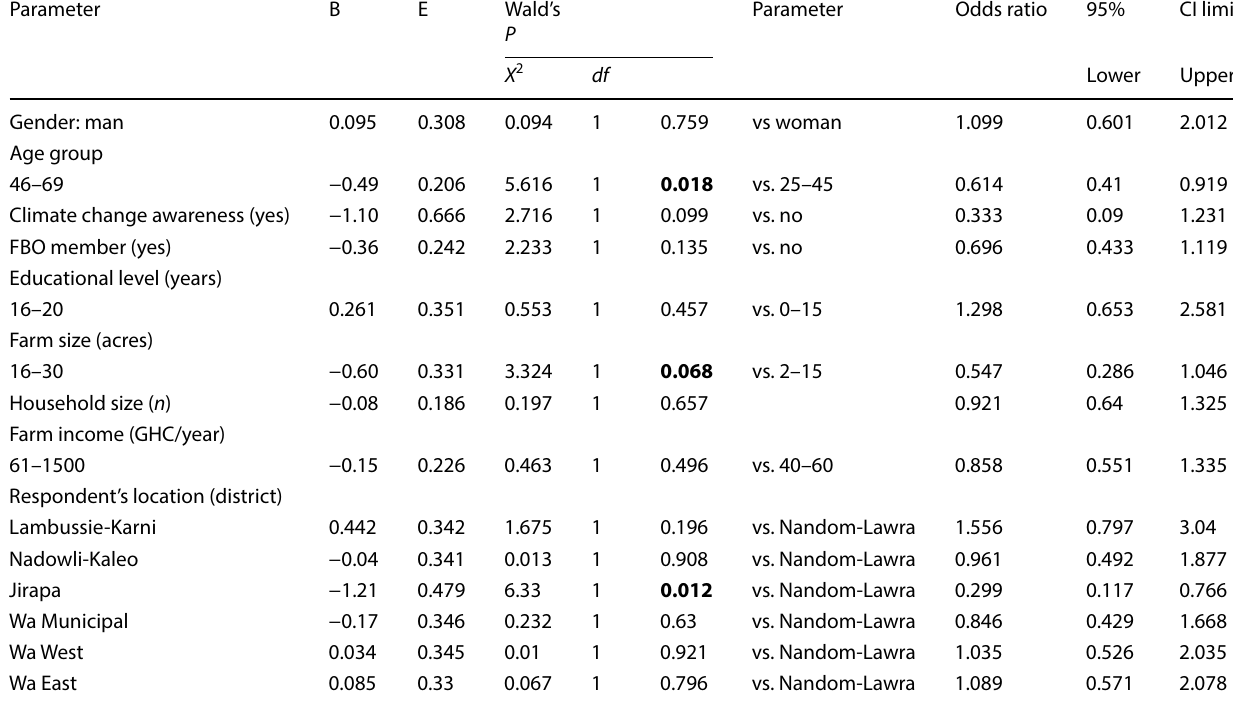
The significant values ( p values) have been provided for these bold values in